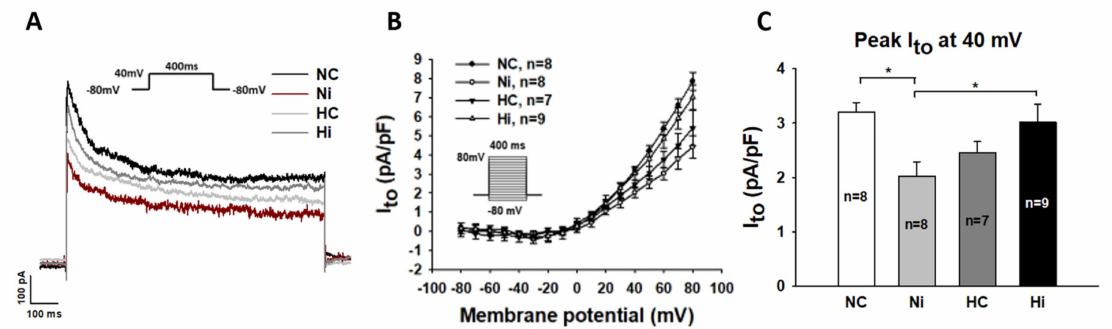
Figure 3. Effects of high-concentration isoprenaline and a high level of glucose on transient outward potassium current (I to ). “NC” represents data from hiPSC-CMs treated with normal level of glucose. “Ni” represents data from hiPSC-CMs treated with normal level of glucose and a high concentration of Iso. “HC” represents data from hiPSC-CMs treated with a high level of glucose. “Hi” represents data from hiPSC-CMs treated with a high level of glucose and a high concentration of Iso. Transient outward potassium current (I to ) was recorded using protocols shown in ( A , B ) (inset). ( A ) Representa- tive traces of peak I to at 40 mV in cells from each group. ( B ) I–V curves of peak I to in cells of each group. ( C ) Mean values of peak I to at 40 mV. Data are presented as mean ± SEM and analyzed by one-way ANOVA with Holm-Sidak post-test. The cell number of every experimental group is given as “n”. * p <